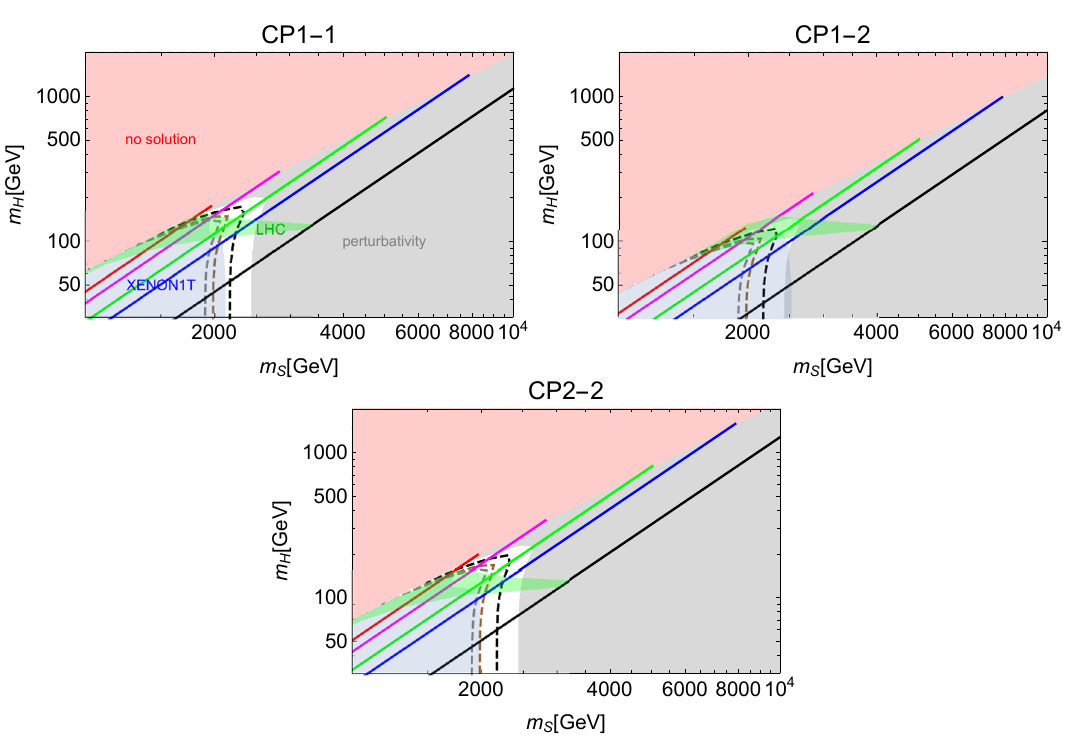
Figure 7 . Same as figure 6, but for the correlation between m S and m H